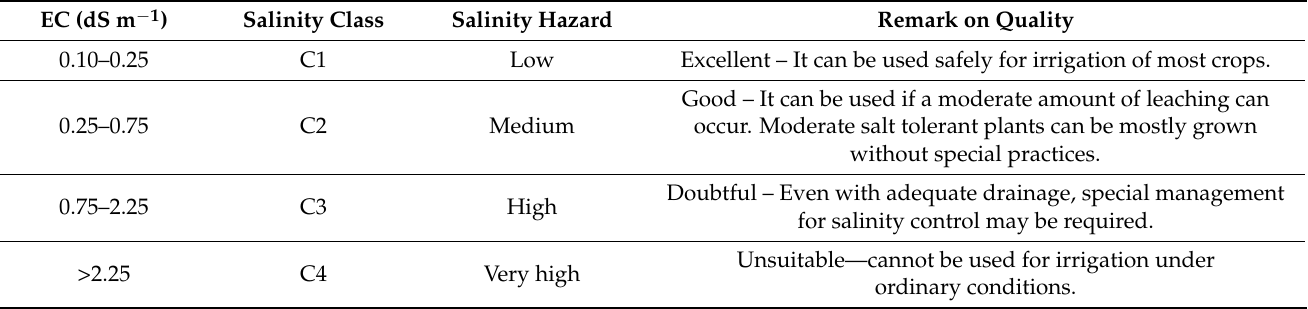
Table 5. Salinity hazard classes